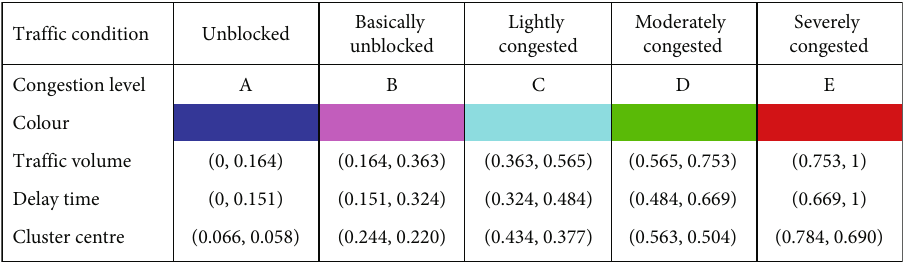
Figure 13: The value range and cluster center corresponding to the two normalized indicators.